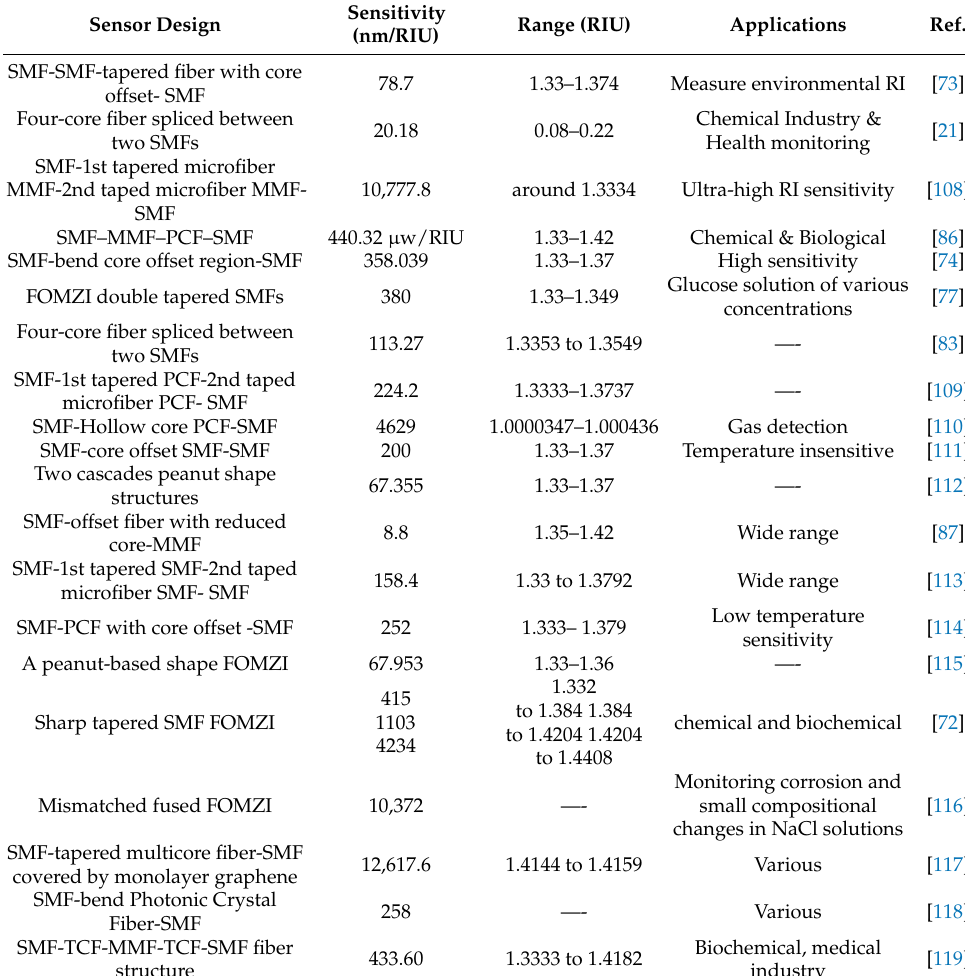
Table 6. Refractive index sensitivity of